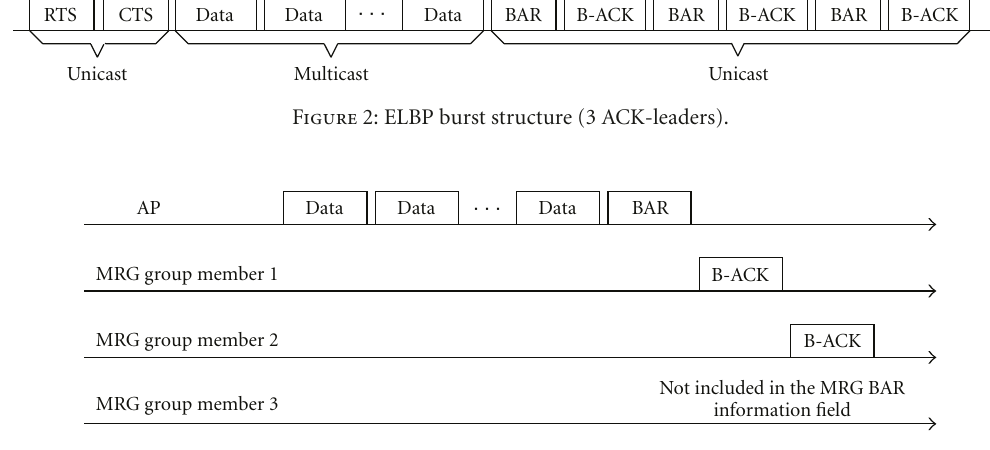
Figure 3: 802.11aa more reliable